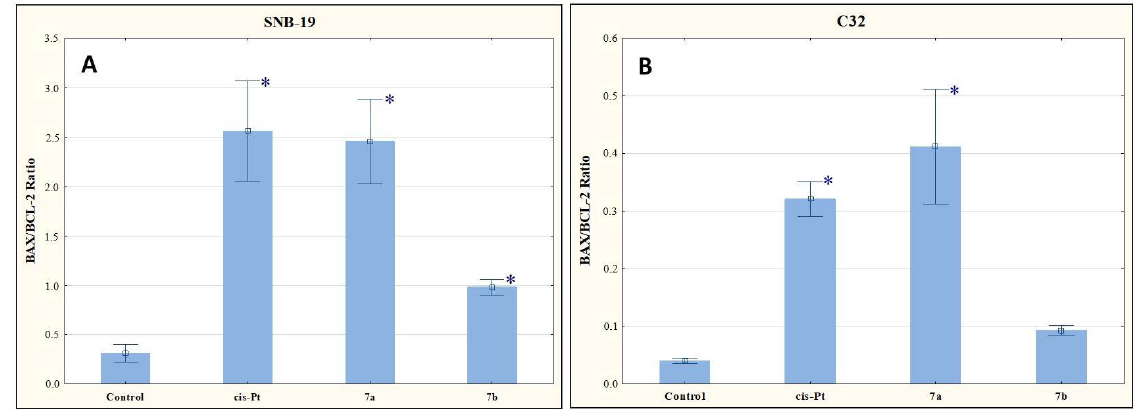
Figure 8. The effect of compounds 7a and 7b on BAX/BCL-2 for SNB-19 ( A ) and C-32 ( B ) cells. Cells were exposed to compound 7a and 7b for 24 h at a concentration equal to half of IC 50 determined for SNB-19 (0.3 and 0.25 µ g/mL, respectively) and for C-32 (0.7 and 0.25 µ g/mL, respectively). For the reference compound, cisplatin, the appropriate concentrations were 0.8 µ g/mL (SNB-19 line) and 0.6 µ g/mL (C32 line). * p < 0.05 compared with the untreated